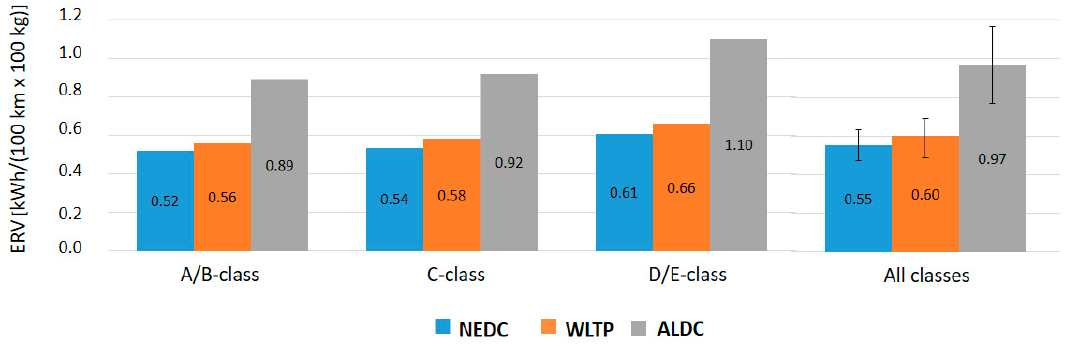
Figure 4. Arithmetic mean of ERV over case studies per vehicle class and driving cycle.